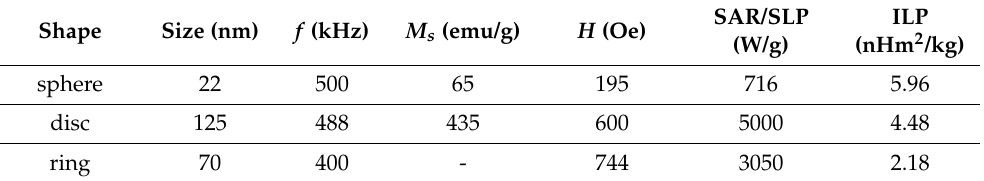
Table 3. Shape and size effect on MNPs’ magnetic heating parameters for Fe 3 O 4 nanoparticles [184,185].